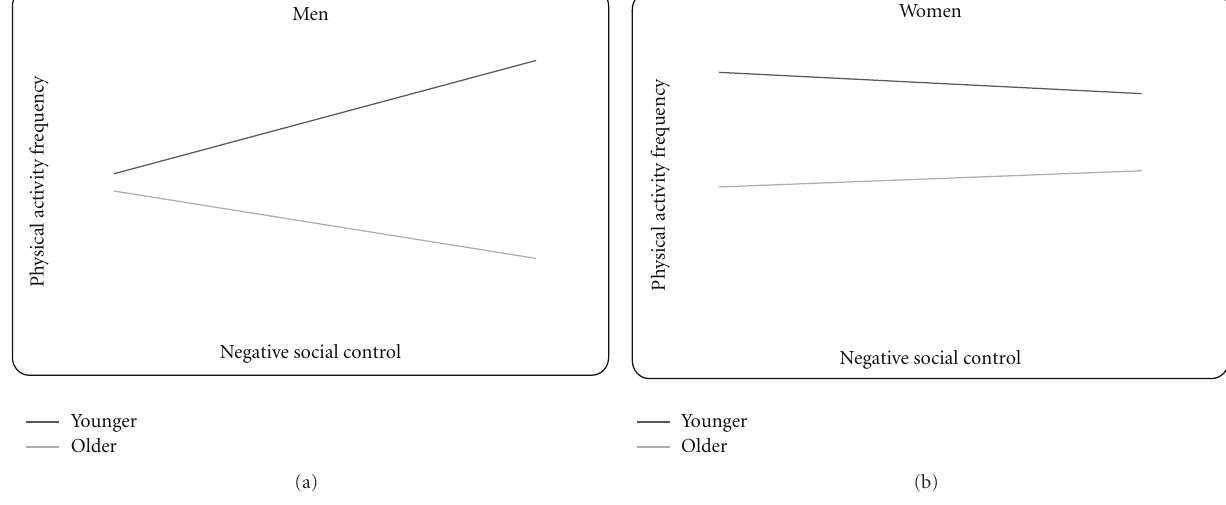
variance in physical activity frequency, F (10, 261) = 7.09, P <